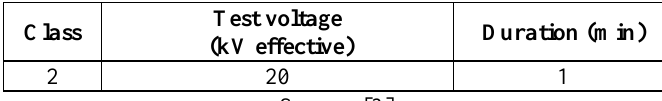
Table 4: Voltages and specified test times for flexible conductor covers.